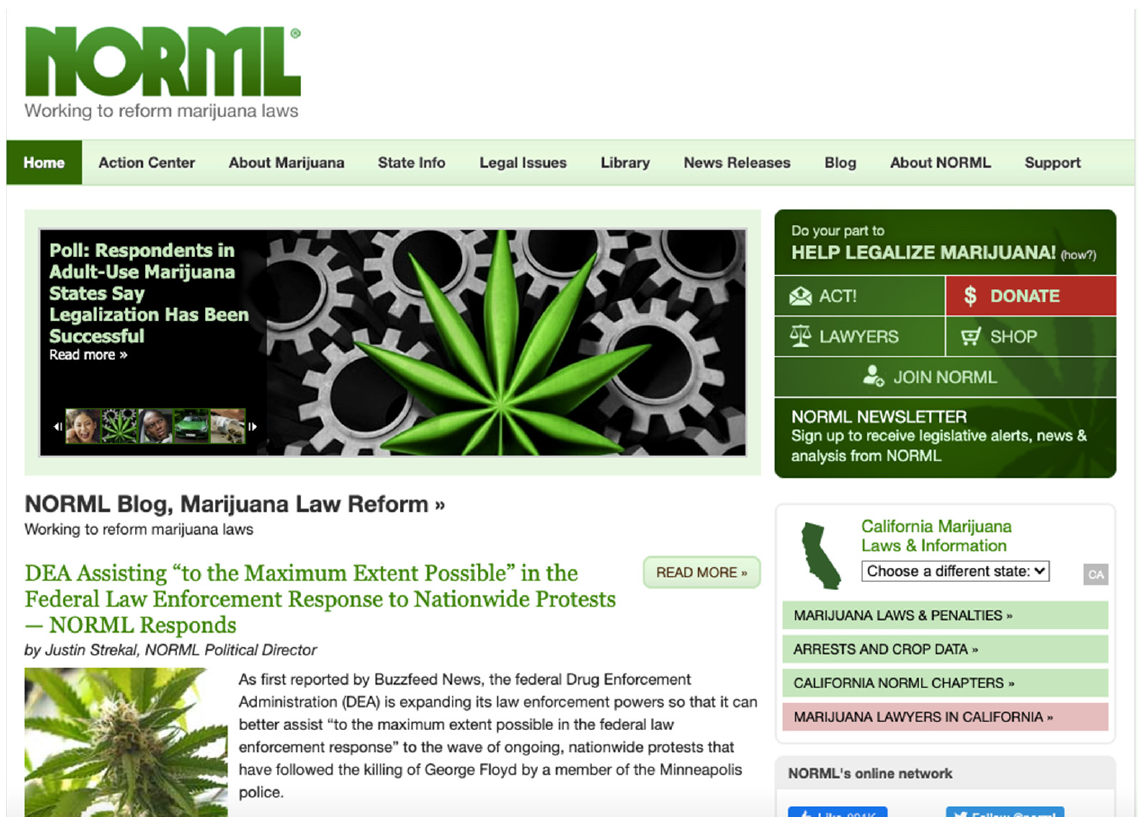
Figure 5. NORML website homepage (https://norml.org/, accessed on 2 November